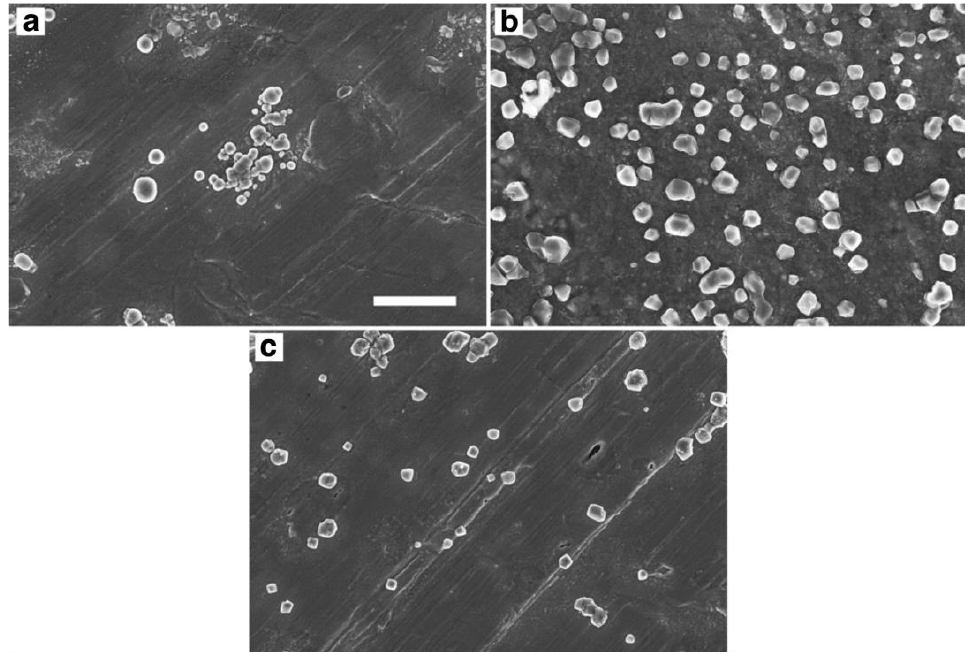
Figure 2. Field emission scanning electron microscopy images of chitosan – cellulose nanocrystal (CNC) polyelectrolyte – macroion complex particles prepared by addition of a CNC-18 suspension to solutions of chitosan with different molecular weights: ( a ) 6·10 3 kDa, ( b ) 3·10 3 kDa, ( c ) 80 kDa. Scale bar (applying to all images): 3 μm.